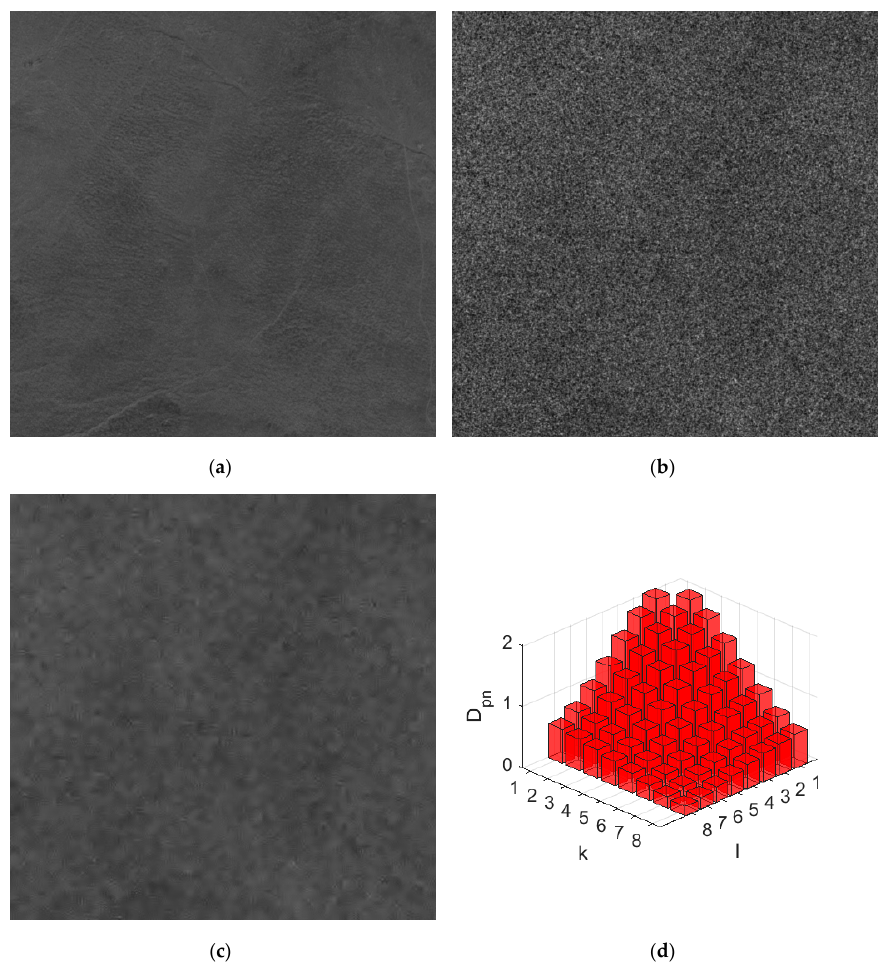
Figure 3. Noise-free ( a ), noisy ( b ) and filtered ( c ) images; normalized DCT spectrum for simulated images ( d